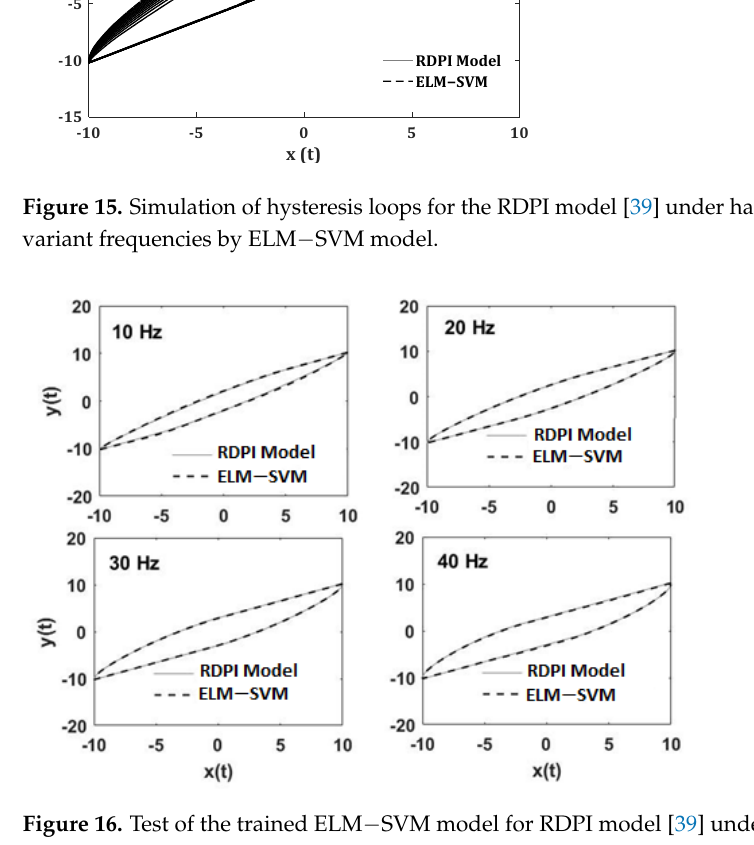
Figure 16. Test of the trained ELM − SVM model for RDPI model [39] under harmonic input signals with variant frequencies .